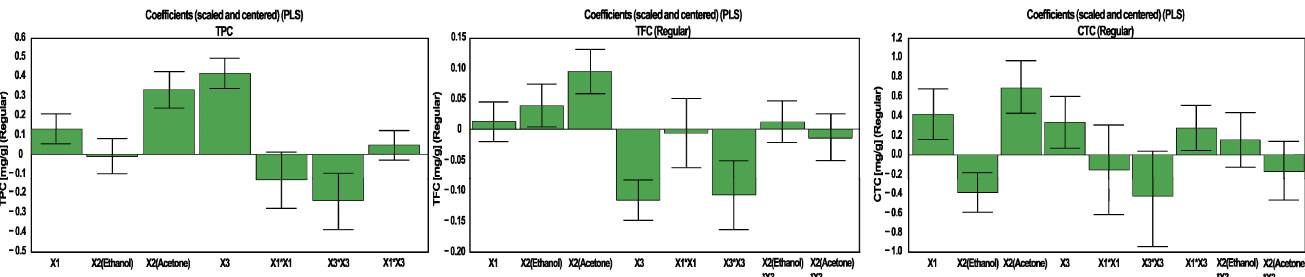
Figure 3. Influence of working conditions on the TPC, TFC and CTC in walnut flower extracts, presented as scaled and centered coefficient plots. X 1 —extraction time (min); X 2 —solvent; X 3 —water in solvent (%, v/v ).